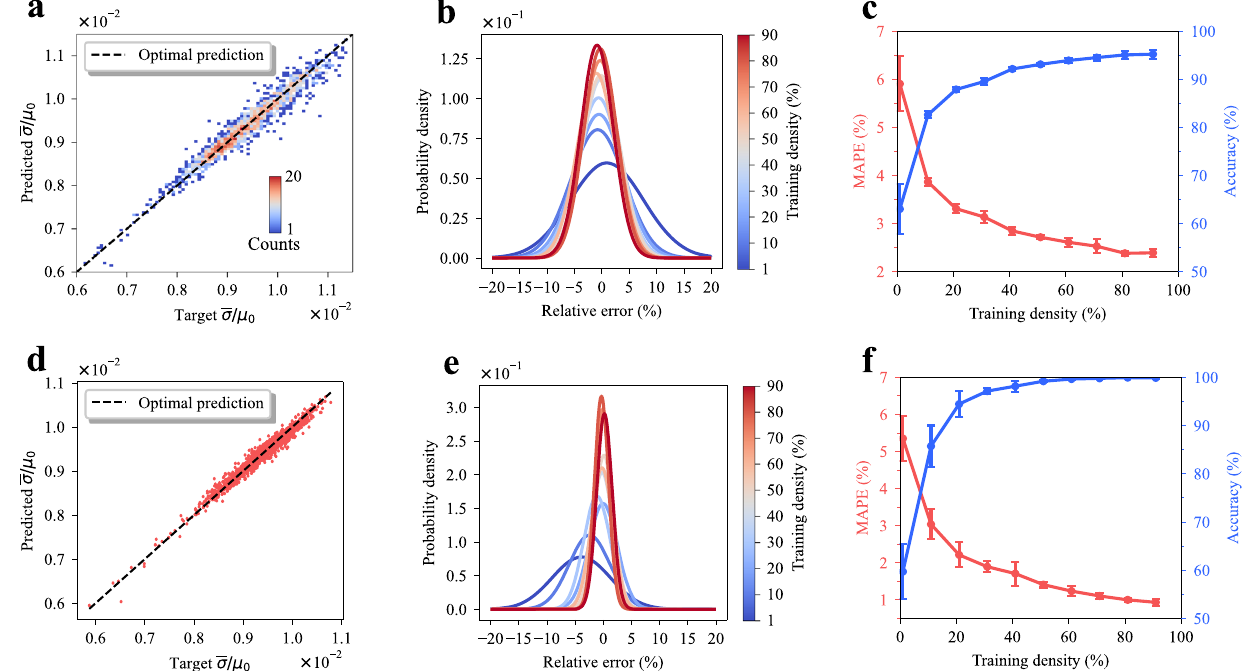
Fig. 3 Nonlinear buckling resistance prediction using DNN. a Predicted vs. target (simulated) normalized buckling strength values (on test data, never seen by the DNN). The number of times a value occurs is indicated as Counts (90 bins are selected in the 2D histogram). b Probability density of the percentage relative error between predicted and test data. A Gaussian density is assumed. c MAPE and accuracy values on test data plotted against training density. Lines are plotted only to facilitate the interpretation. d Predicted vs. target (simulated) normalized mean buckling strength values, averaged over the loading directions. e Probability density of the percentage relative error between predicted and average data. A Gaussian density is assumed. f MAPE and accuracy values on average data plotted against training density. One run, optimized network ’ s hyperparameters and training density of 80% is considered, if not otherwise speci fi ed. Lines are plotted only to facilitate the interpretation. Error bars correspond to one standard deviation computed over 5 algorithm, we run optimization rounds for 100 iterations until 12